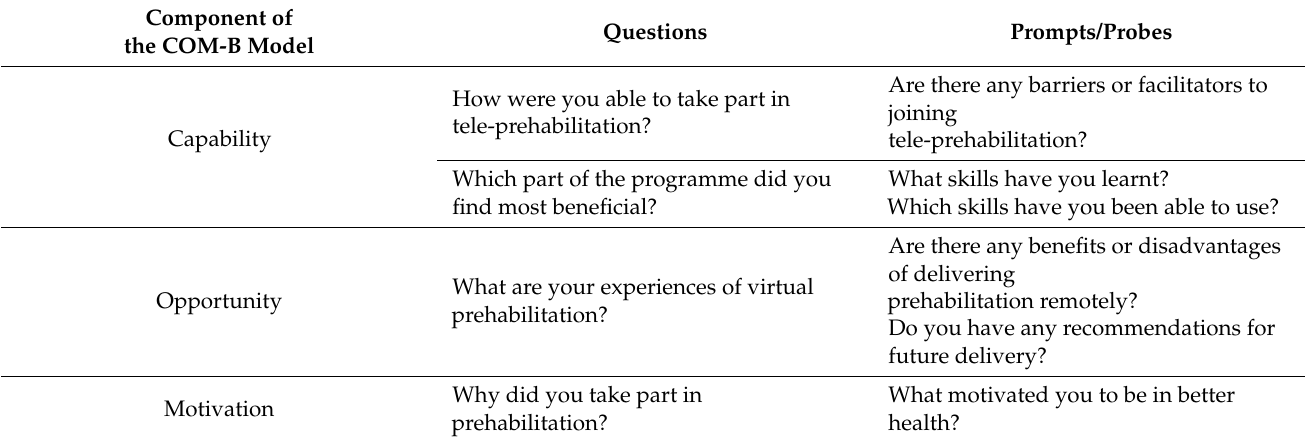
Table 1. Interview guide used to facilitate the